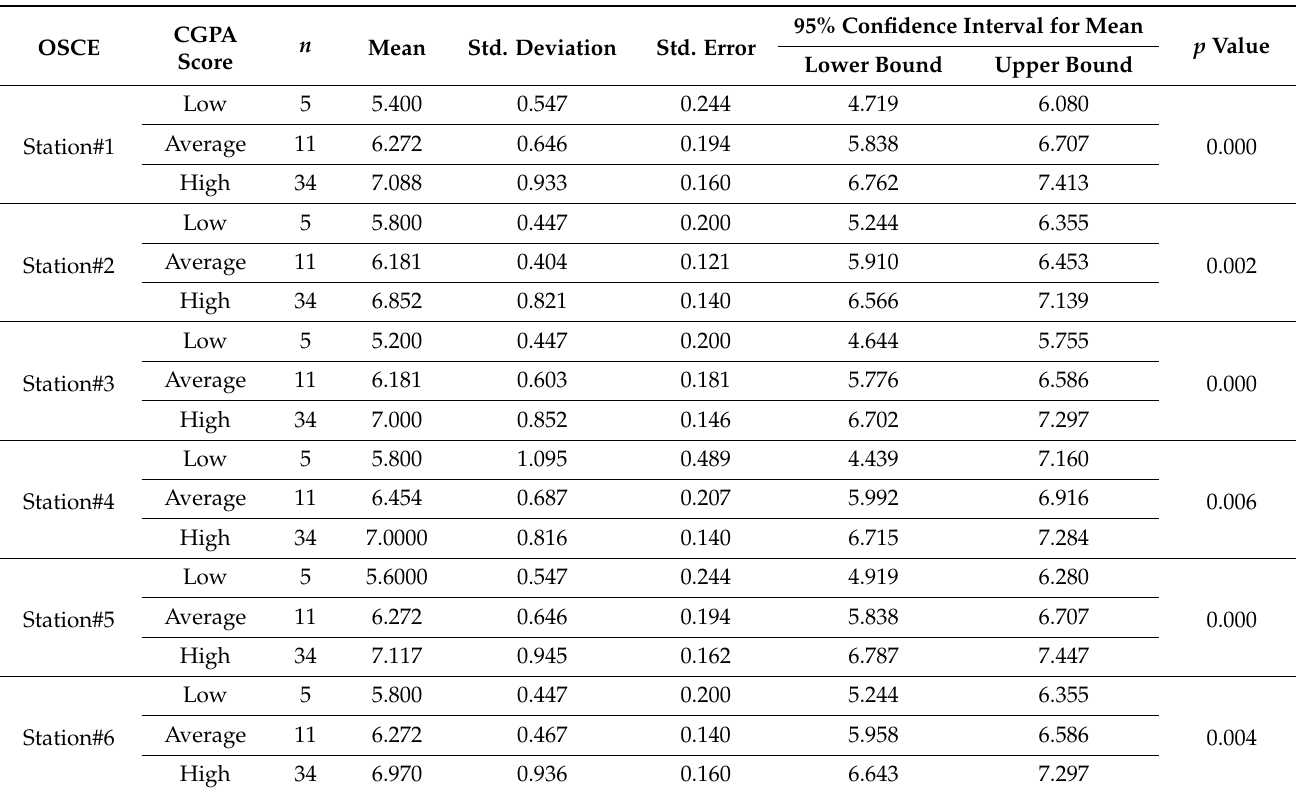
Table 3. Comparison of OSCE stations scores with respect to cumulative grade point averages (CGPA) groups (low, average and